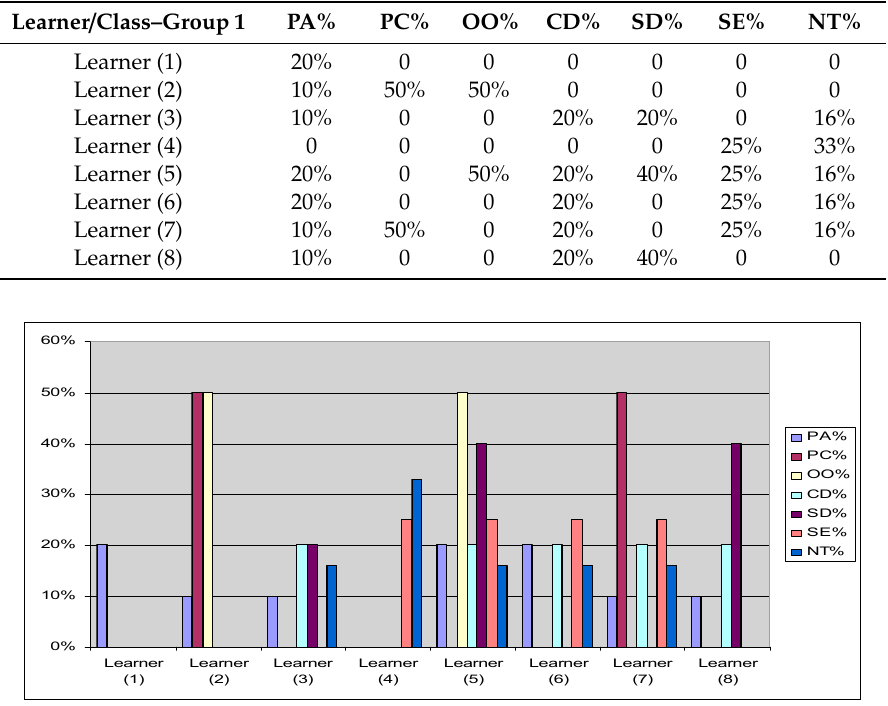
Figure 23. Learners’ participation ratio for Group 2. The comparison among the learners’ collaboration within each class of Group 3 is shown in Figure 24. It is clear that Learner (3) has the most group participation in problem solving within the group (PA = 10%, PC = 100%, OO = 50%, CD = 33%, SD = 25%, SE = 50%, NT = 33%). On the other hand, Learner (4) has the minimum group participation (PA = 10%, SE = 20%, NT = 33%). Moreover, it can be noticed that Leaner (3) has PC = 100%. In this case, the social agent engages other leaners in the group to do more contributions with Learner (3) in class PC. Figure 24. Learners’ participation ratio for Group 3.